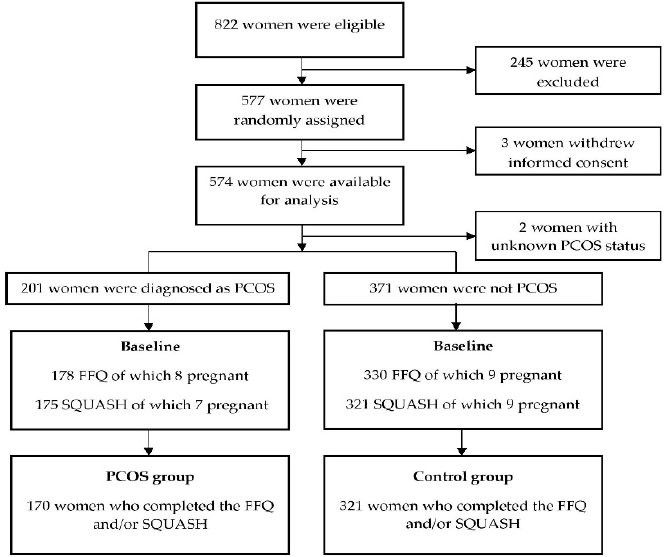
Figure 1. Flow chart of the participants who completed the FFQ and/or SQUASH at the baseline. PCOS: polycystic ovary syndrome, FFQ: food frequency questionnaire, and SQUASH: Short QUestionnaire to ASsess Health-enhancing physical activity. Table 1. Baseline characteristics of the participants who completed the FFQ and/or SQUASH at the baseline.